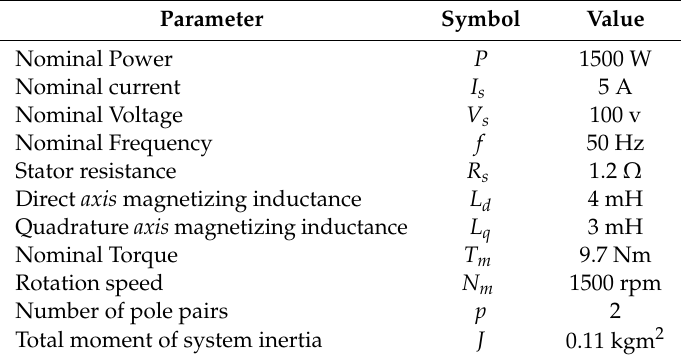
Table 1. The PMSG parameters